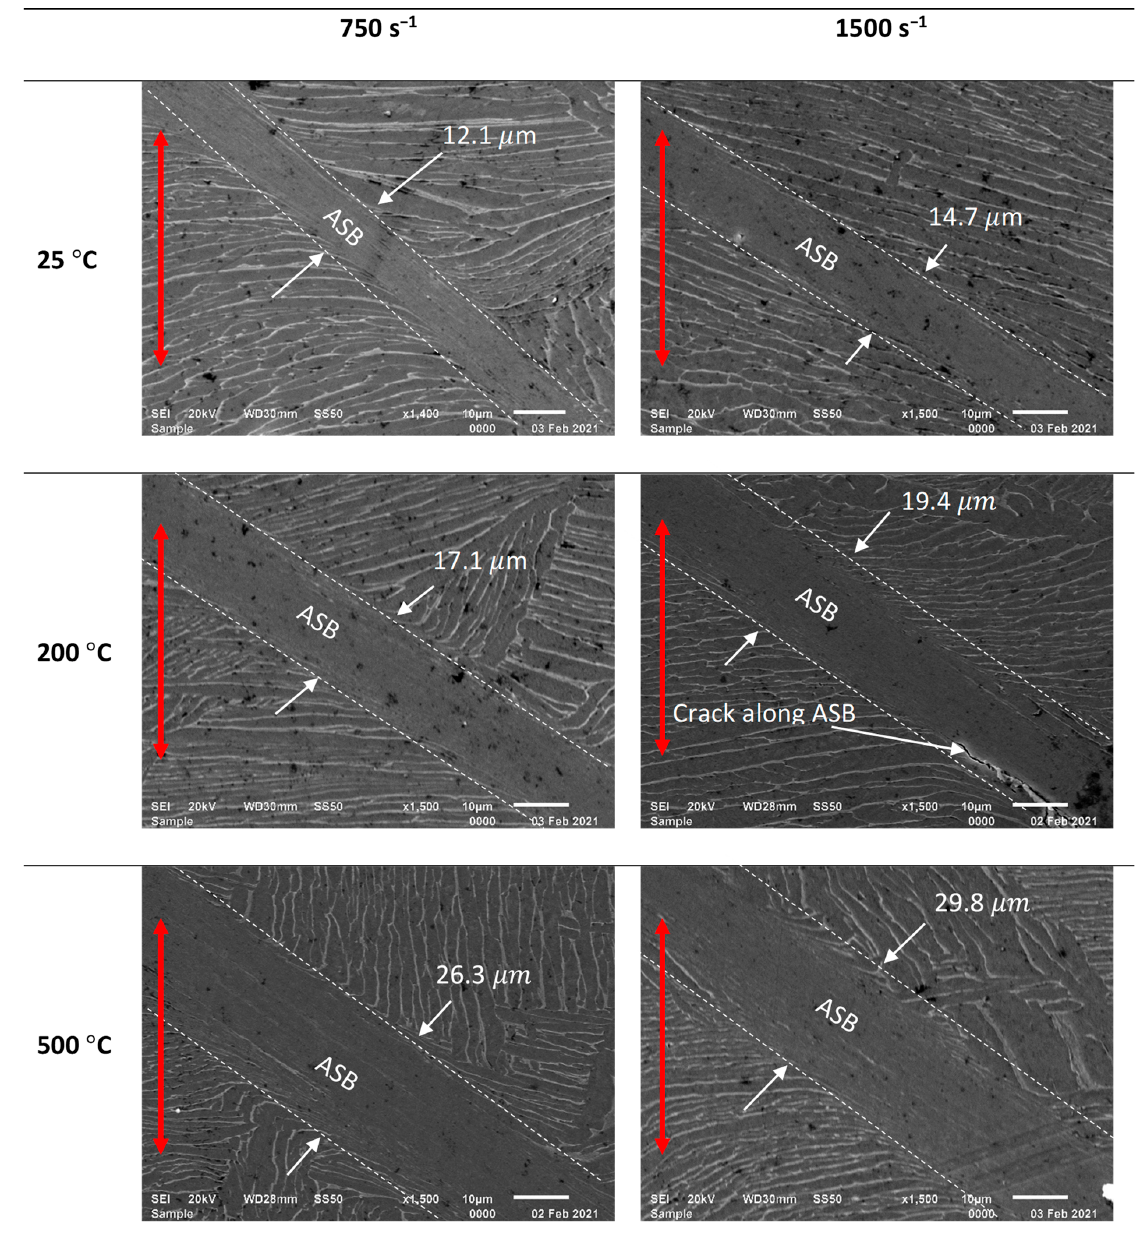
Figure 16. Secondary electron images showing adiabatic shear bands on sections of deformed surfaces of samples E at different strain rates and temperatures (the red arrows indicate the compression loading axis).